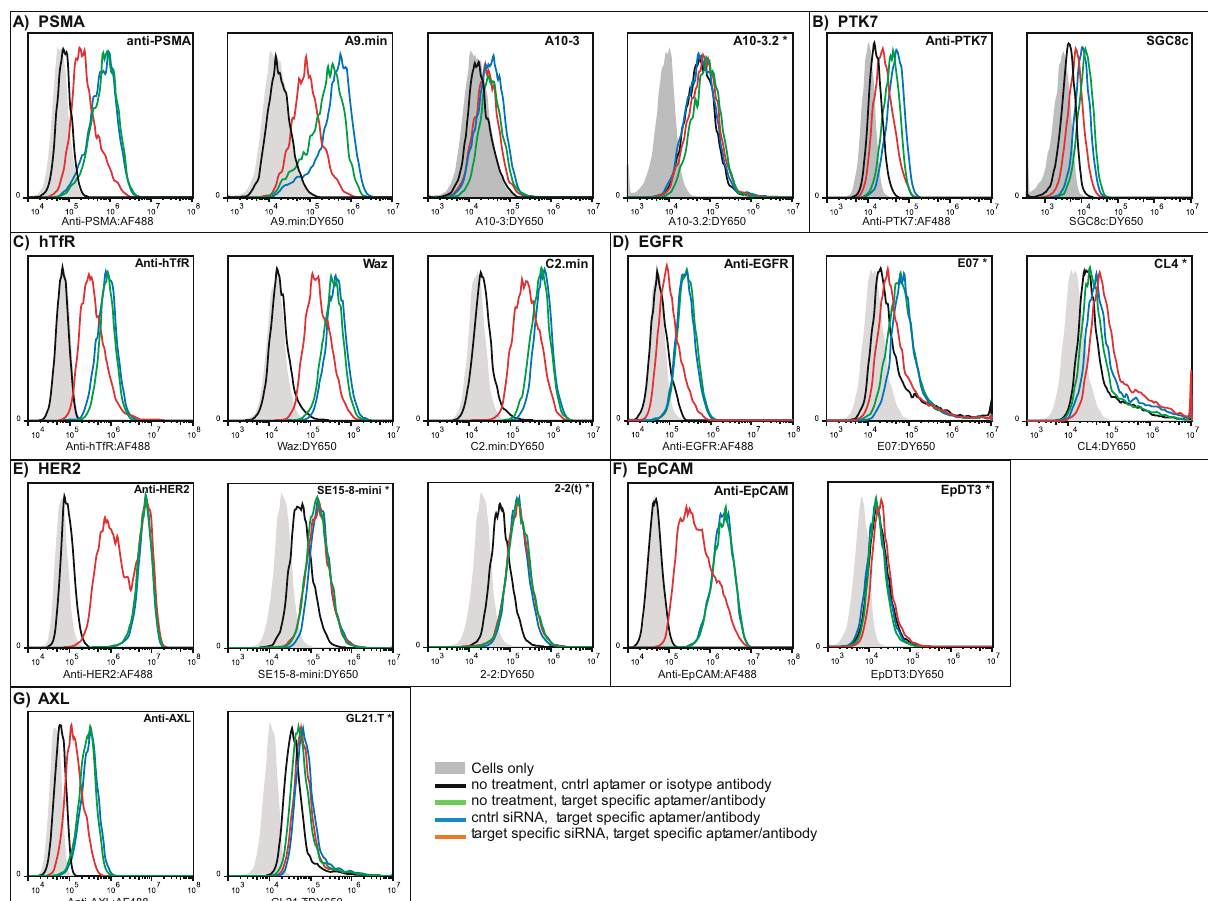
Fig. 4 Validation of speci fi city using target-speci fi c siRNA. Cell lines were transfected with siRNA speci fi c for each aptamer ’ s reported target (red) or a non-speci fi c siRNA control (blue) and subsequently stained with a target-speci fi c antibody or aptamer. Aptamer or antibody binding to untreated cells are shown in green and non-targeted controls (isotype antibody or the non-targeting aptamer C36) are shown in black. Untreated cells are indicated in gray. All assays were performed at 37 °C using our internalization and binding with blocking protocol except for those denoted with an asterisk. The asterisk denotes experiments performed in the absence of blocking agents (see text for details). The cell type and aptamer concentration used for each experiment were: A LNCaP cells: A9.min (100 nM), A10-3 (100 nM), and A10-3.2 (500 nM); B A431 cells: SGC8c (100 nM); C HeLa cells: Waz (100 nM) and C2.min (100 nM); D HeLa cells: E07 (500 nM) and CL4 (1000 nM); E SKBR3 cells: SE15-8-mini (1000 nM) and 2-2(t) (1000 nM); F MCF7 cells: EpDt3 (1000 nM); and G HeLa cells: GL21.T (1000 nM). Data are representative of two independent experimental